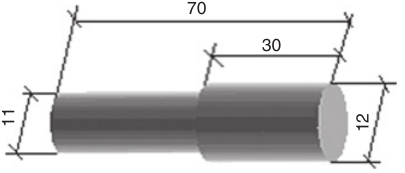
Figure 1 Dimension of samples used in the